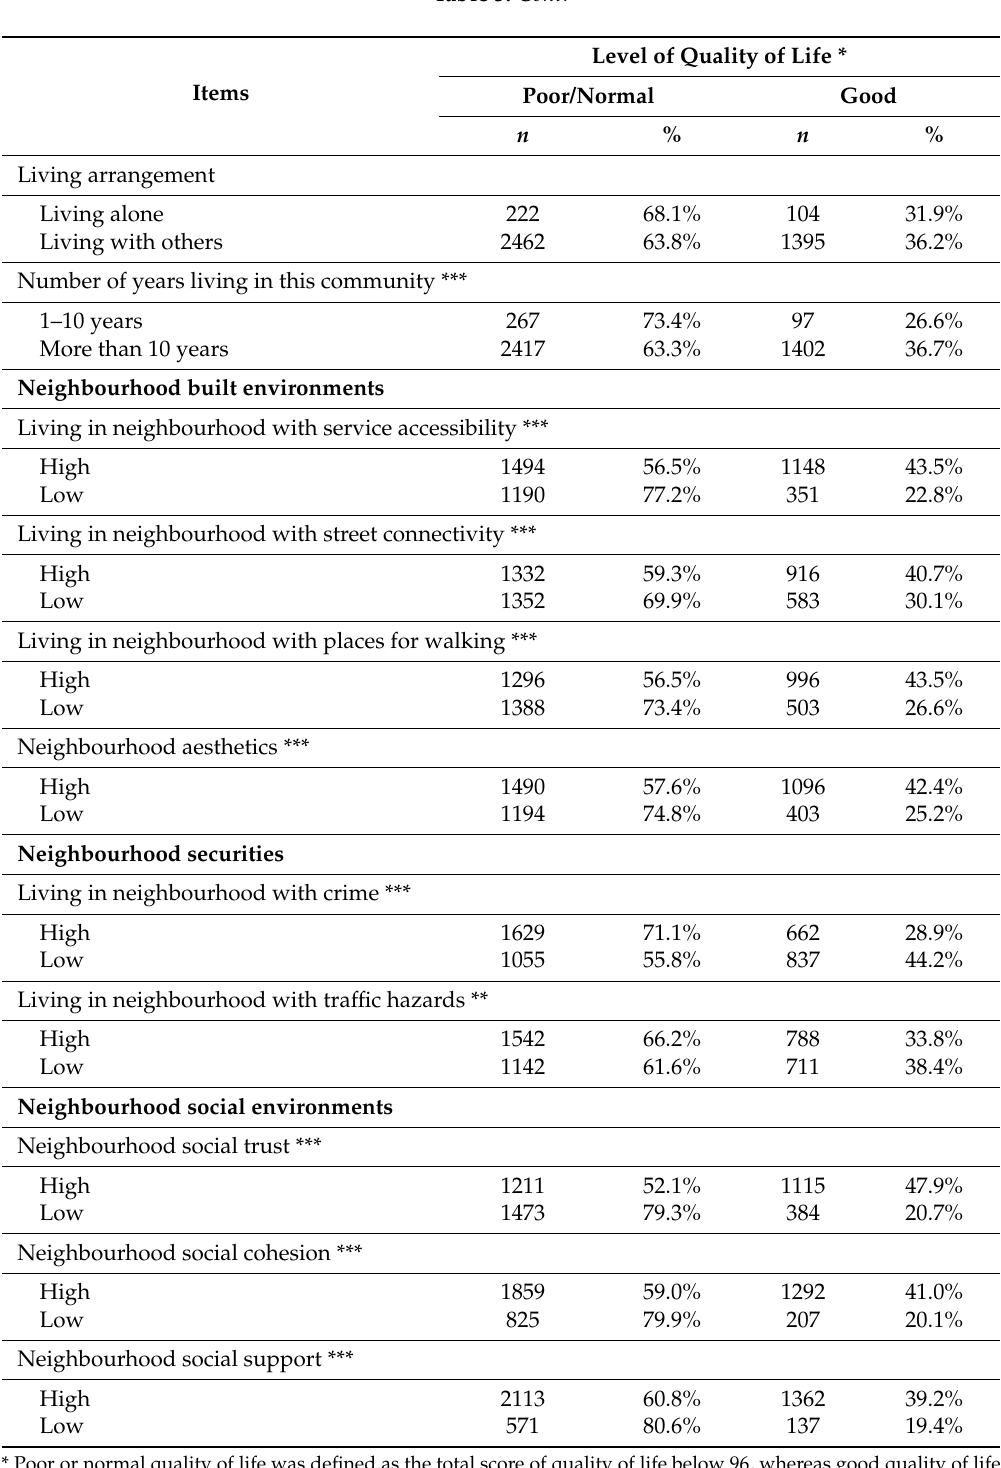
Table 4 indicates the predictors of quality of life among the Thai older population. The results of multivariable logistic regression indicate that older adults who perceived a higher level